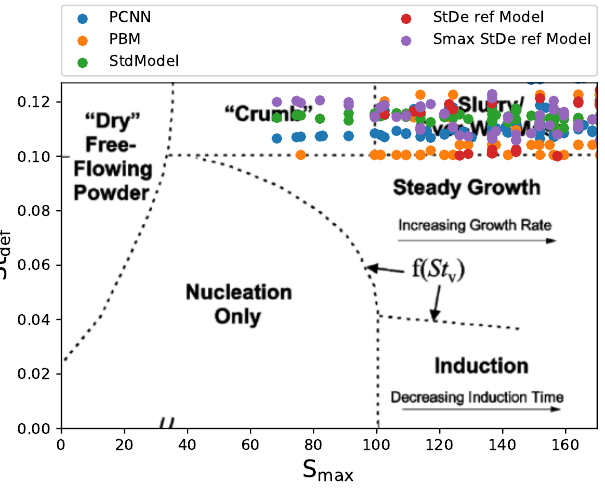
Figure 5. Comparing the predictions from all 4 model with the test data (PBM). This plot contains all the points where the predictions indicated St def > 0.1. The PCNN performs better than the other data-driven